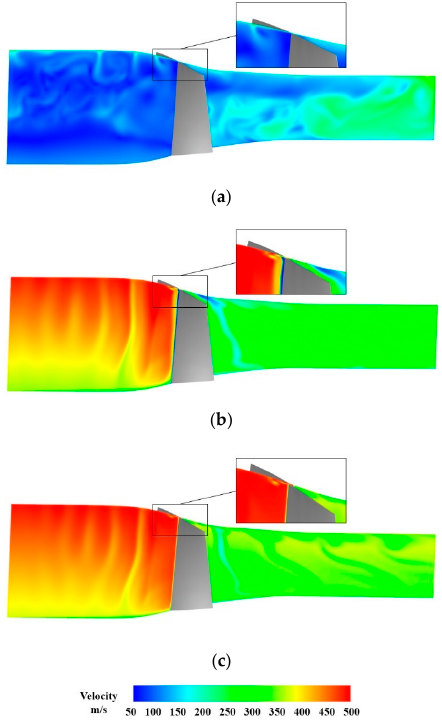
Figure 6. Relative velocity fields on the meridian plane of the NASA rotor 37 at ( a ) NS condition, ( b ) design condition, ( c ) NC condition.